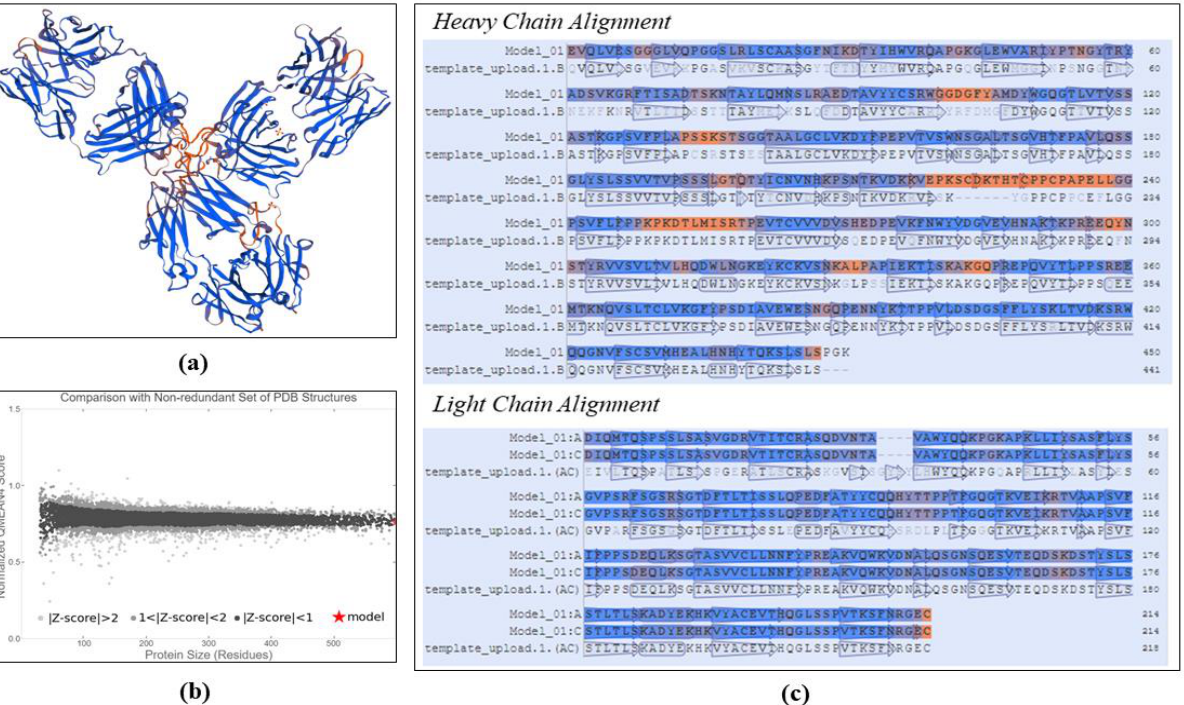
Table 3. Evaluation of trastuzumab modeling results.